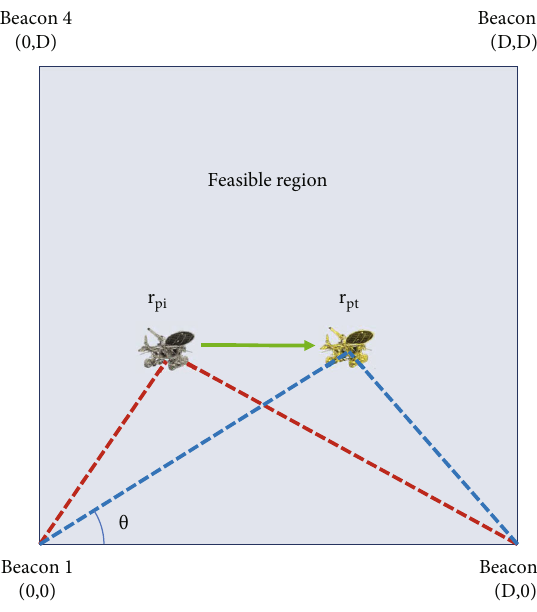
Figure 3: The geometry of the beacons and the probe of Group